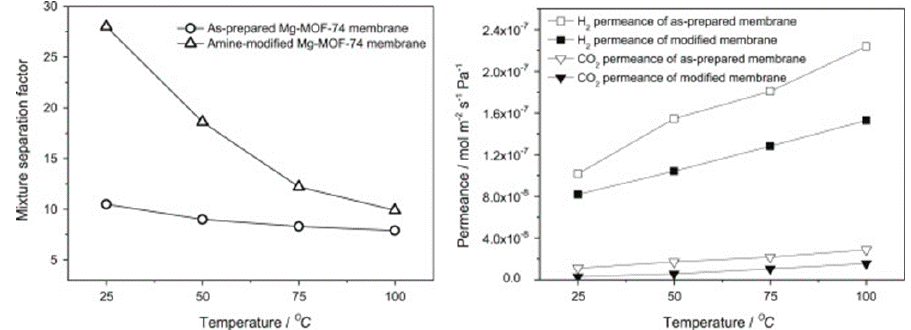
Figure 35. Mixture separation factors for H 2 /CO 2 from equimolar mixture ( left ) and single gas permeances of H 2 and CO 2 ( right ) on the as-prepared and amine-modified Mg-MOF-74 membranes at 1 bar as a function of temperature. (adapted with permission from ref. [77]).